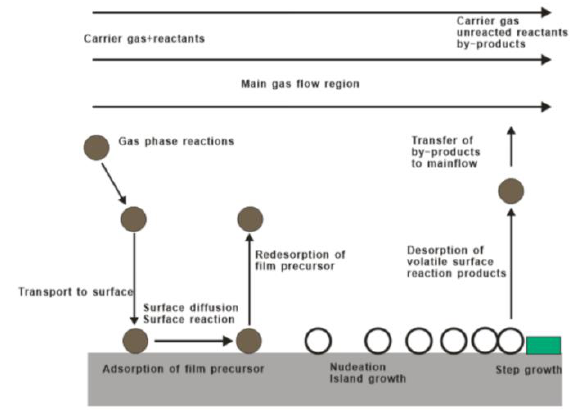
Figure 2. Basic reaction diagram of chemical vapor deposition.